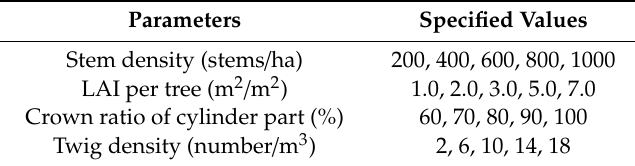
Table 7. Four key variables for sensitivity analysis and their discretized values.